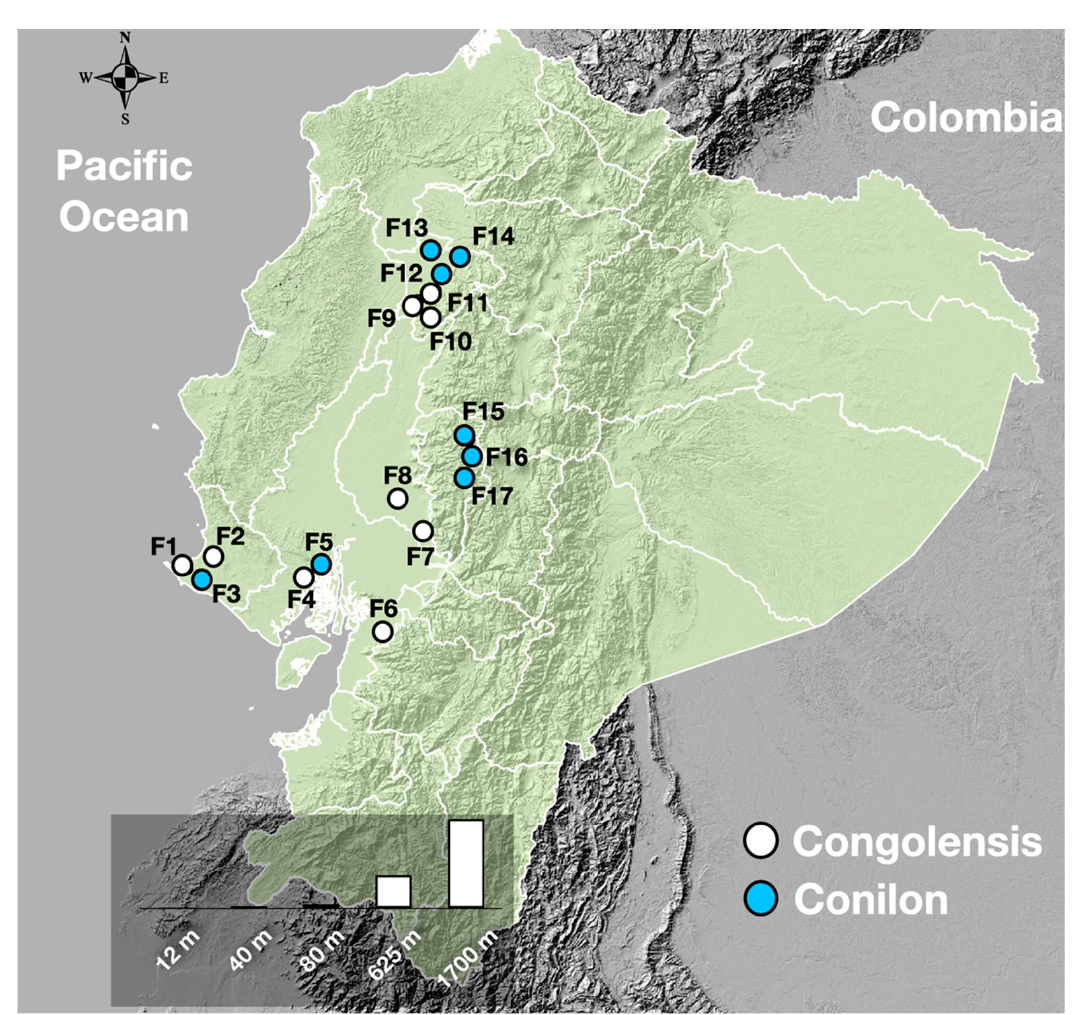
a,b Precipitation and temperature refer to annual mean values.